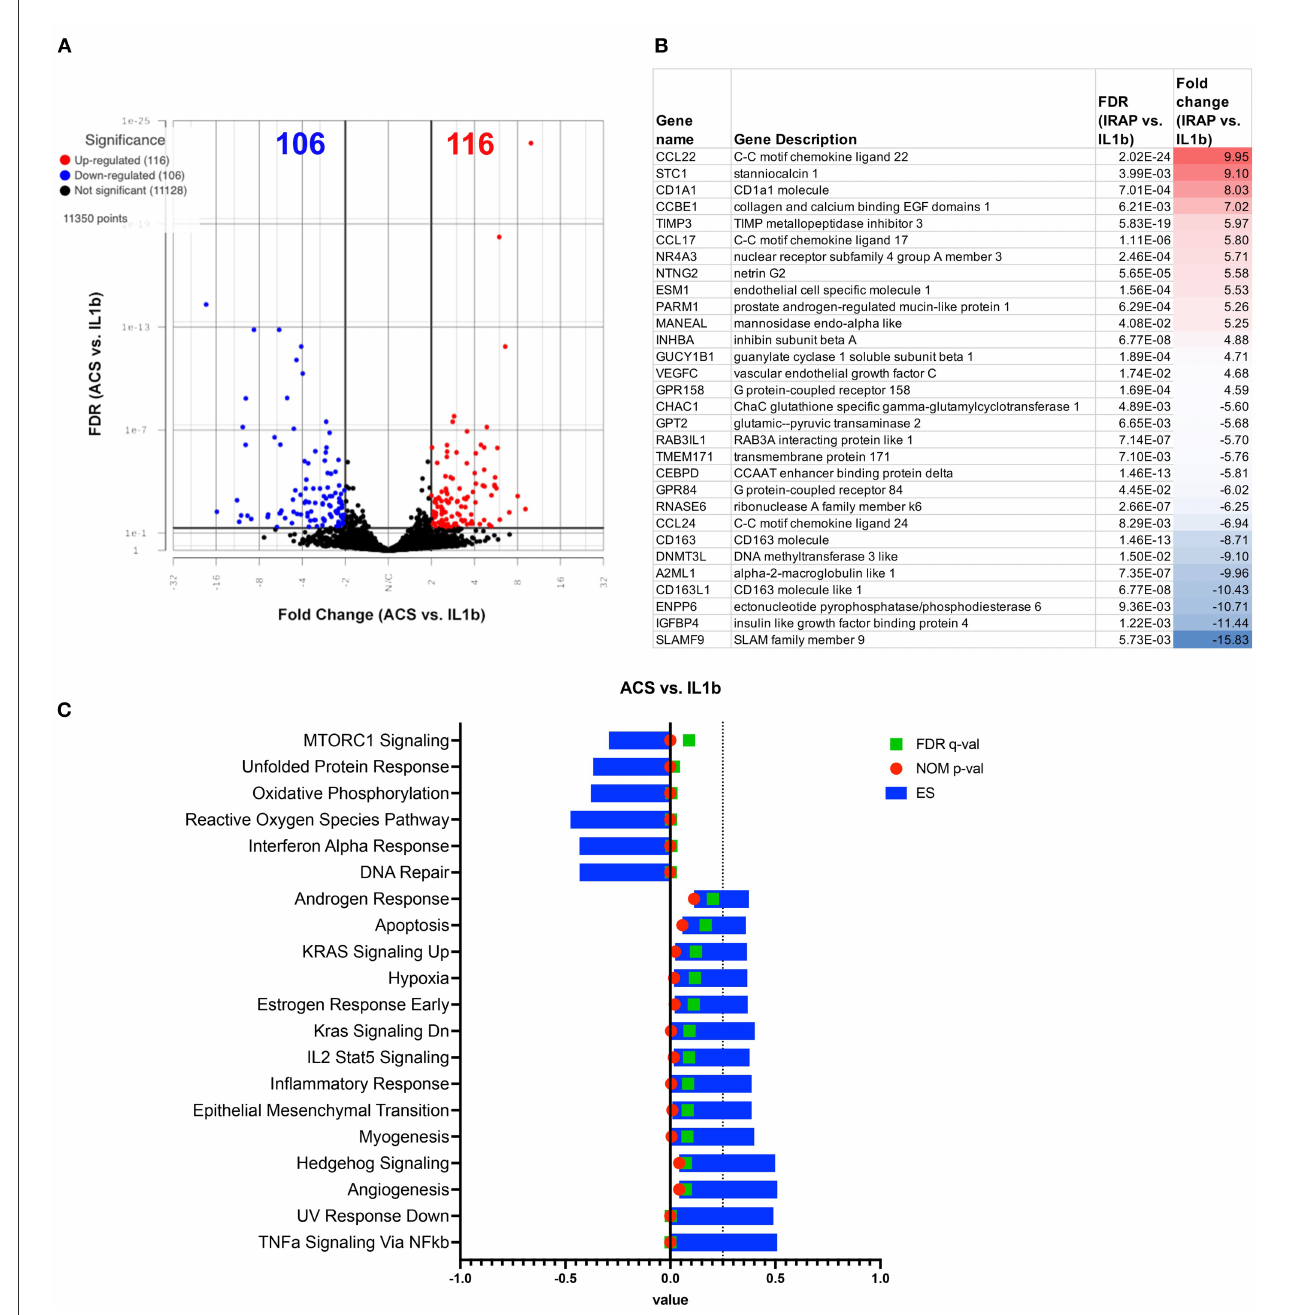
FIGURE7 Differential gene expression and pathway analysis of ACS treated macrophages compared to IL-1ß stimulated. (A) Volcano plot of ACS treated vs. IL-1ß. X-axis shows fold change and y-axis shows unadjusted adjusted p -value. Significance defined as FDR adjusted p -value ≤ 0.05 fold change ≥ 2 or ≤ − 2. (B) List of genes, description, FDR, and fold change of top 15 upregulated and downregulated genes in differential analysis results from ACS vs. IL-1ß stimulated samples. (C) GSEA results using normalized counts from n = 3 ACS treated vs. IL-1ß stimulated macrophages. Blue bars show ES, green FDR significant values, and nominal p -values shown in